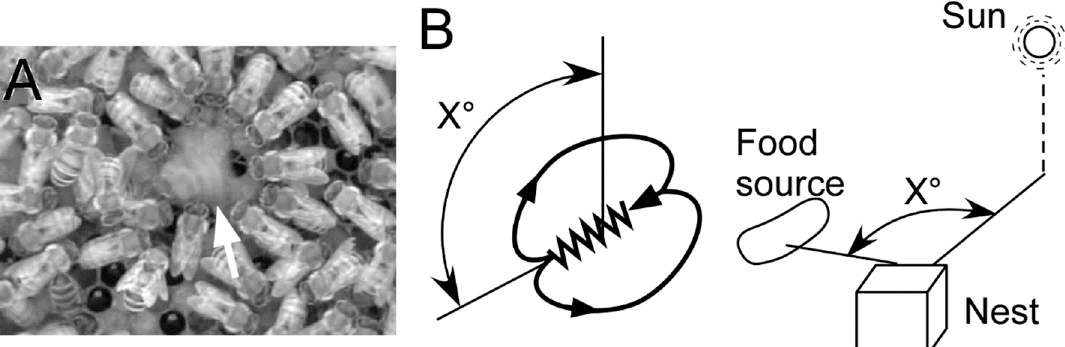
Figure 1. The waggle dance. ( A ) A dancer (arrow) on the waggle run and many bees (followers) around the dancer. ( B ) Encoding a direction of a food source. The direction of a waggle run in relation to the position of the sun when dancing on a horizontal comb and in relation to upwards/anti-gravity when dancing on a vertical comb indicates/represents the direction of a food source.